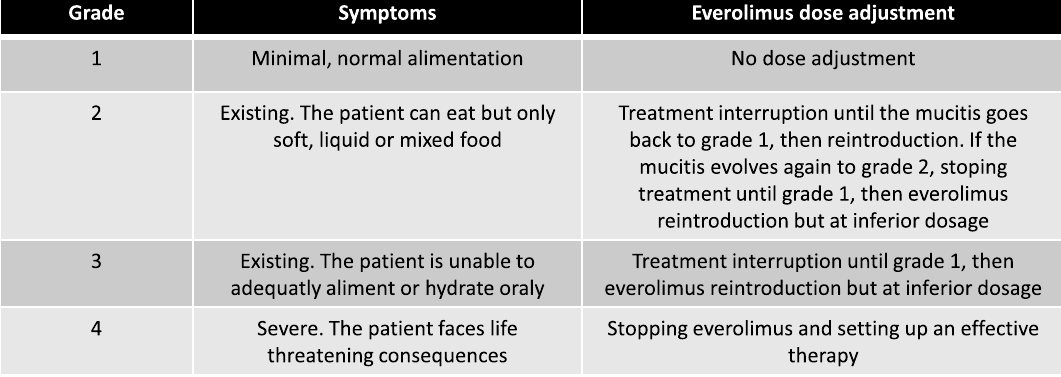
Fig. 4. Dose adjustment of